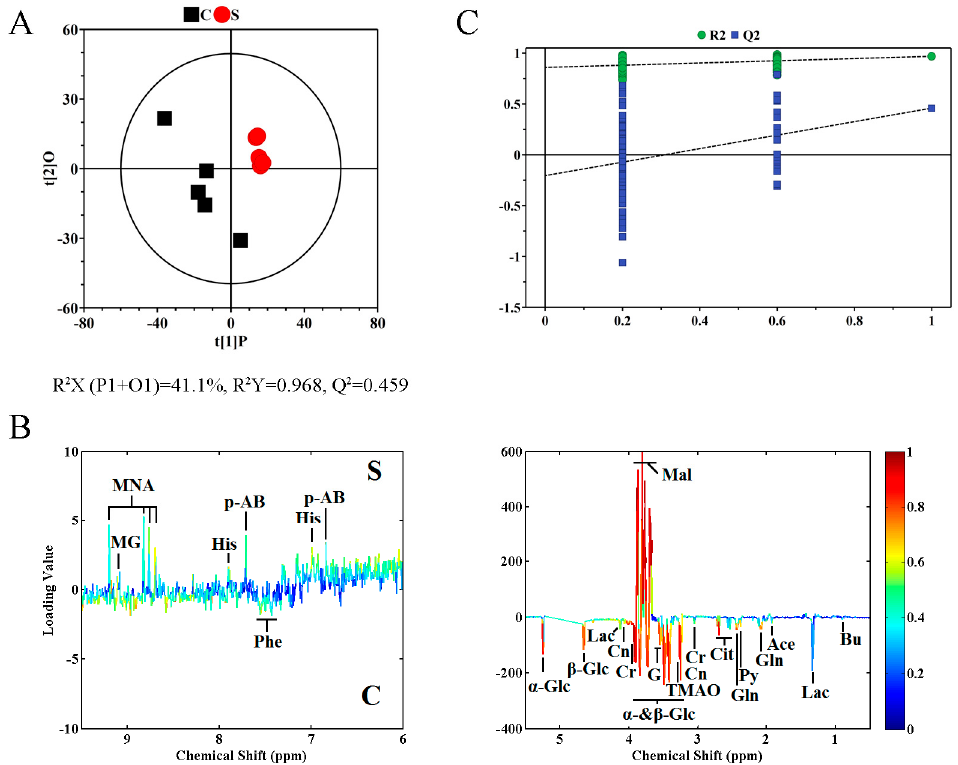
Figure 4. Orthogonal projection to latent structure with discriminant analysis (OPLS-DA) scores plots ( A ) derived from 1 H NMR spectra of A549 cells. Corresponding coefficient loading plots ( B ) obtained from groups C and S and cross validation ( C ) by permutation test ( n = 200). The significance of metabolites variations between the two classes is shown in a color map. Peaks in the negative direction demonstrate metabolites of group C are more abundant. In the group S, if metabolites are more abundant, the peaks will in the positive direction. Figure 2 shows the keys of the assignment.